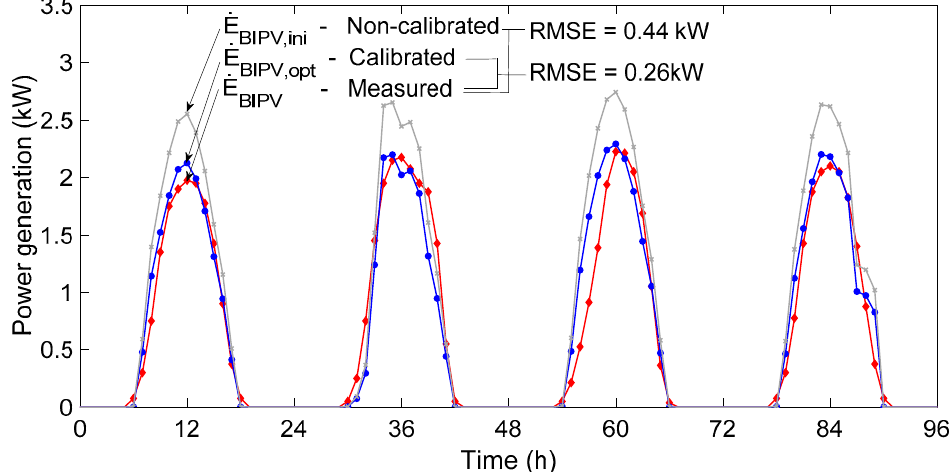
Figure 9. Results of calibrated and noncalibrated models for BIPV power production (first four days). Prior to calibration, (cid:1846) (cid:2913)(cid:2915)(cid:2922)(cid:2922),(cid:2919)(cid:2924)(cid:2919) had an RMSE of 6.92 °C compared to (cid:1846) (cid:2913)(cid:2915)(cid:2922)(cid:2922) , and it was reduced to an